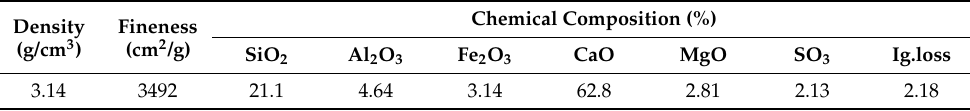
Table 3. Physical properties and chemical composition of the cement.